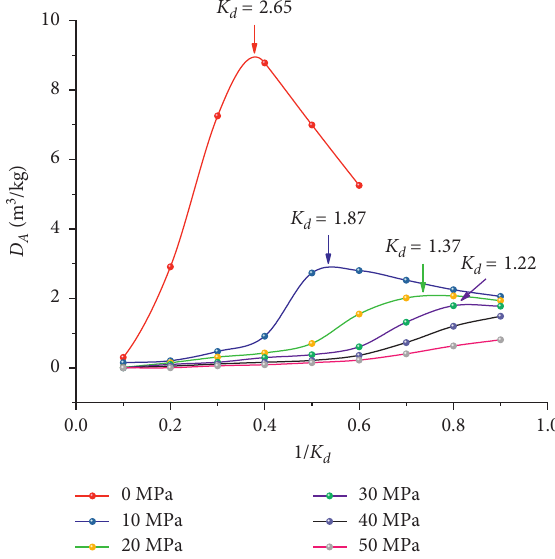
Figure 18: D A curves under different in situ